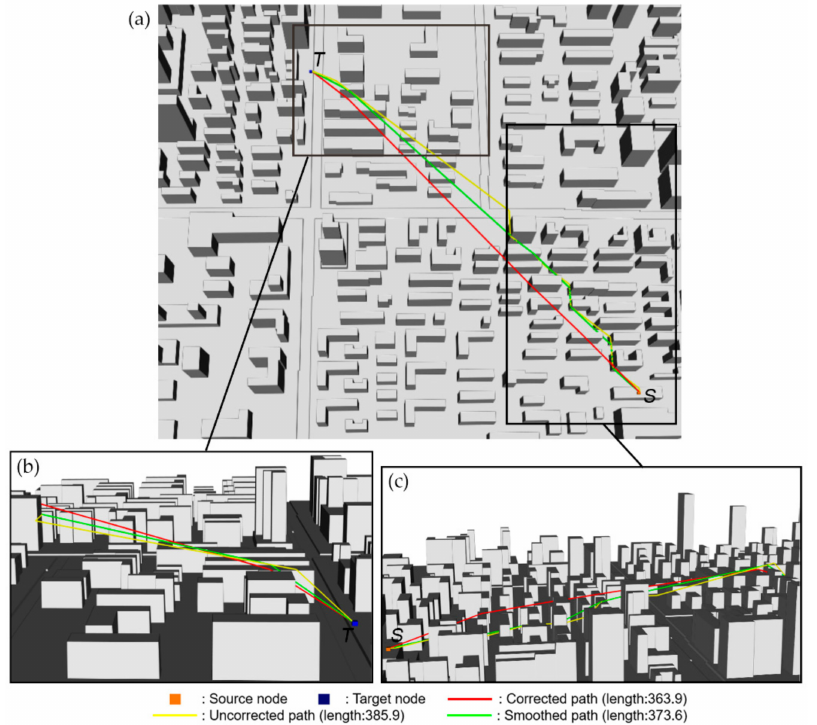
Figure 7. Obtaining the shortest 3D drone delivery route in a city environment. ( a ) Top view and ( b , c ) two magnified side views of the 3D